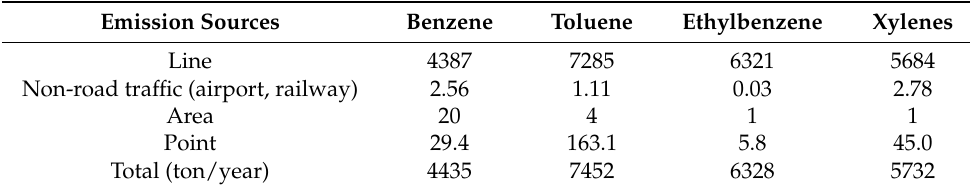
Table 7. Total BTEX emissions from the four main sources of air pollutants of BTEX in HCMC